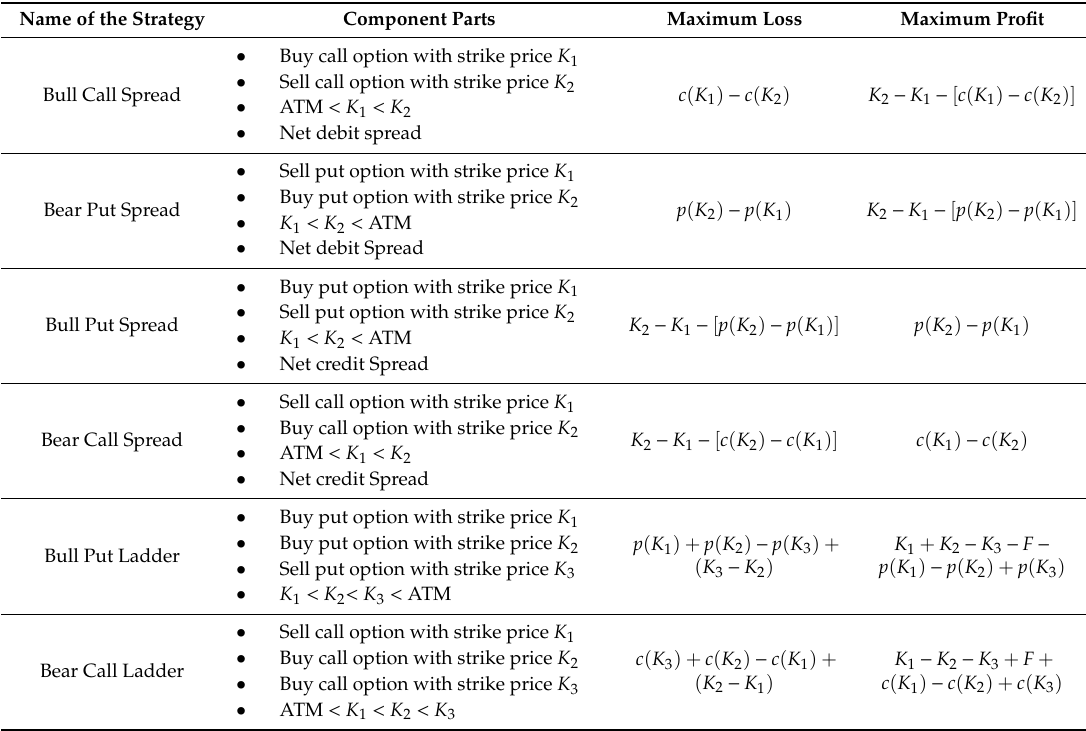
Table 1. Characteristics of vertical spread option